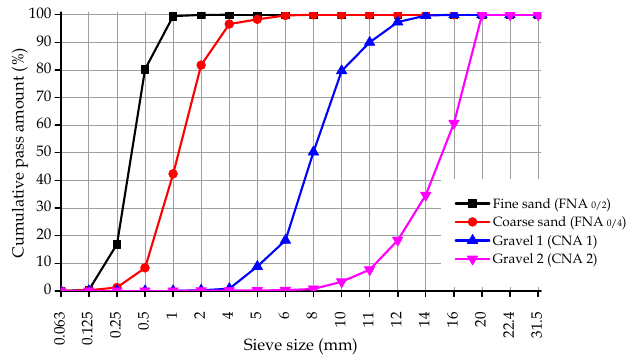
Figure 1. Particle size distribution of the aggregates.